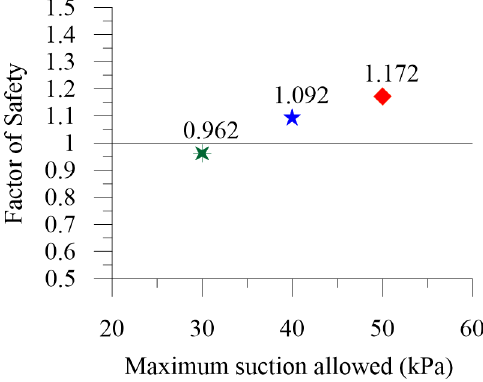
Figure 5. Factor of safety variation with pore pressure initial conditions.